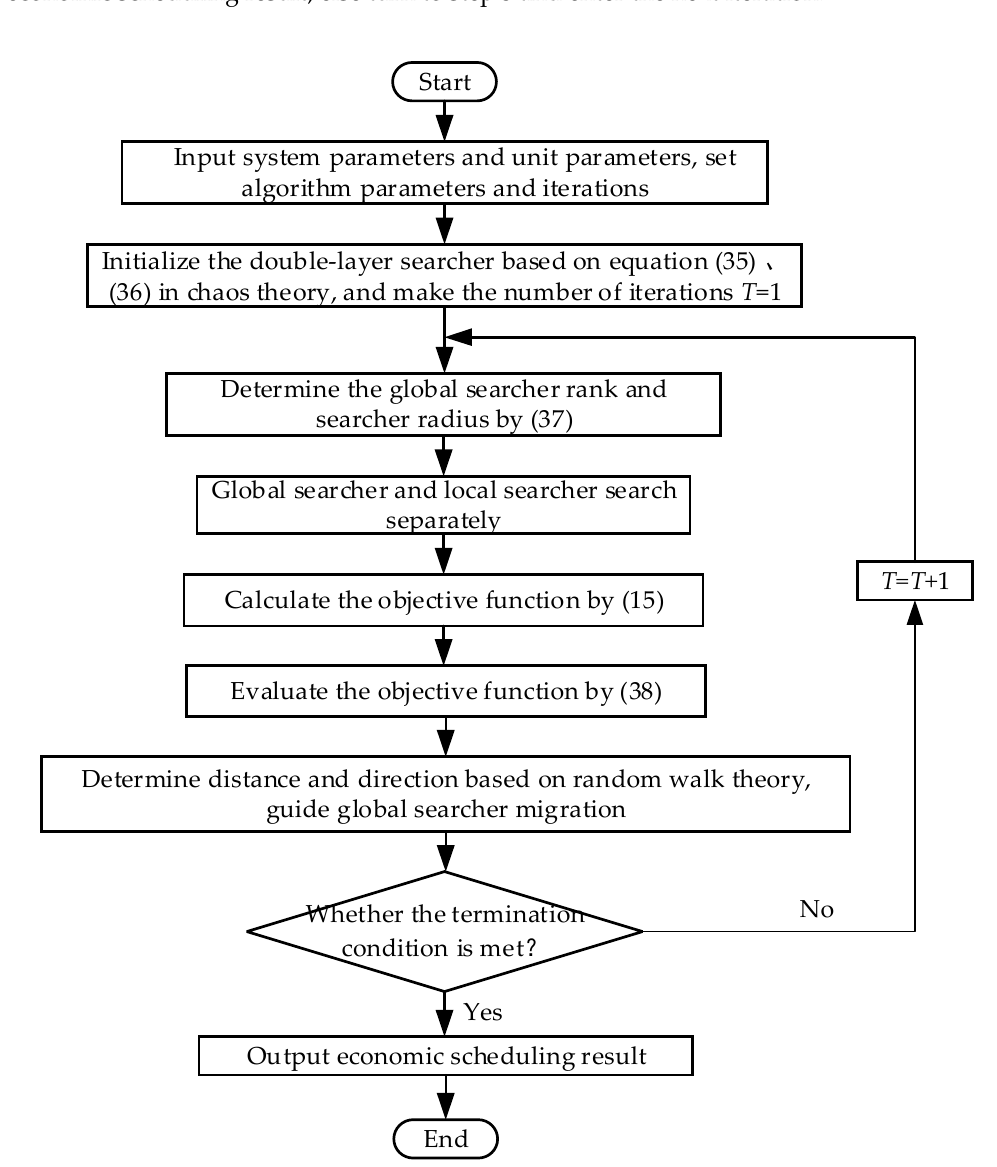
Figure 5. Execution procedure of the multi-searcher optimization (MSO) for optimal energy dispatch (OED).